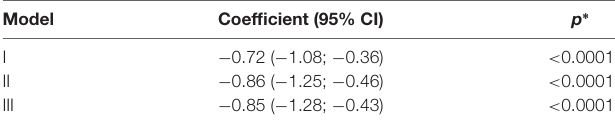
TABLE 2 | Association between abdominal visceral fat and CDR-SB ( n = 234). Model